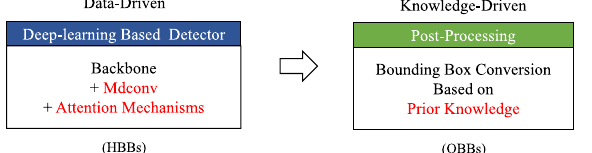
Fig. 1 Principle of the proposed